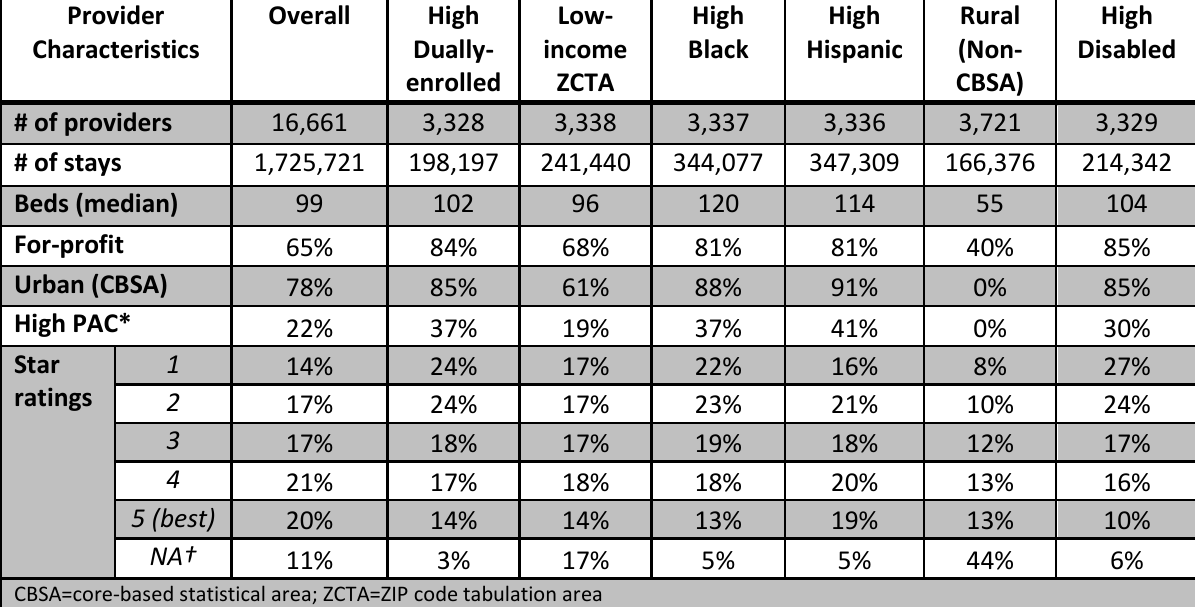
Table 12.2: SNF Characteristics, Fiscal Year 2014 Provider